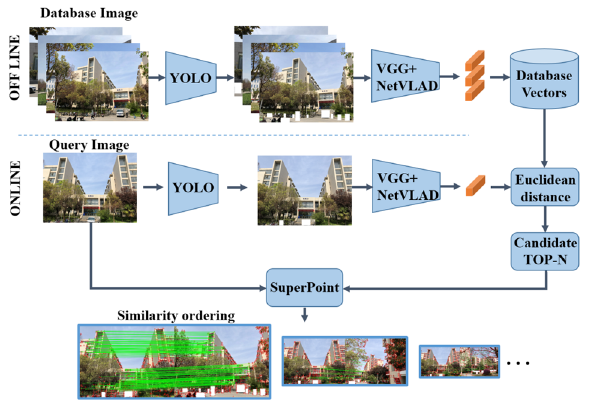
Figure 7. Solution C. After removing the interference area in the image, the subsequent retrieval process is carried out according to Solution B.